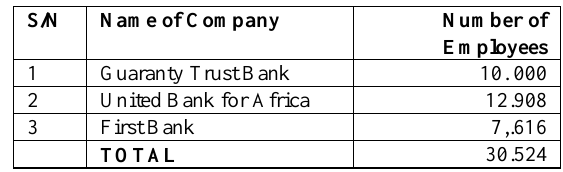
Table 1: The Number of Employees of Selected Banks